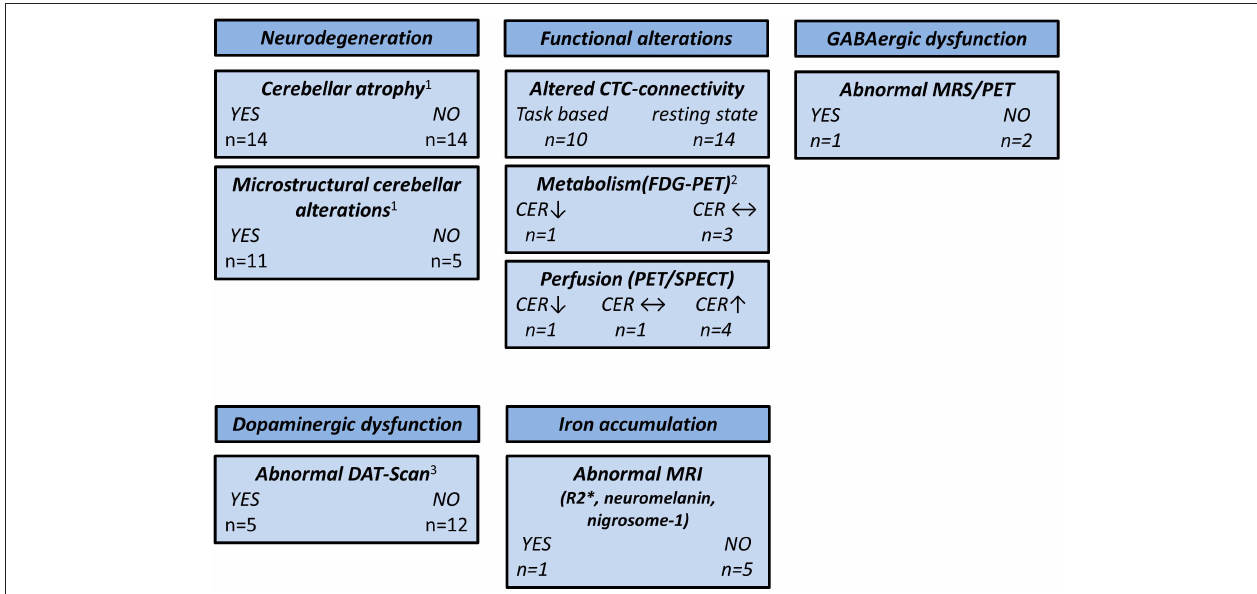
FIGURE 2 | Overview of neuroimaging studies in essential tremor. CER, cerebellum; CTC, cerebello-thalamico-cortical; DAT, dopamine transporter; FDG, 18 F-fluorodeoxyglucose; GABA, γ -aminobutyric acid; MRS, magnetic resonance spectroscopy; MRI, magnetic resonance imaging; PET, positron emission tomography; SPECT, single-photon emission computed tomography; ↑ , higher compared with the healthy controls; ↓ , lower compared with the healthy controls; ↔ , no difference compared with the healthy controls. 1 CER not assessed by three studies. 2 CER not assessed by one study. 3 One study used 11 C-CFT PET and two studies used [ 99m Tc]-TRODAT